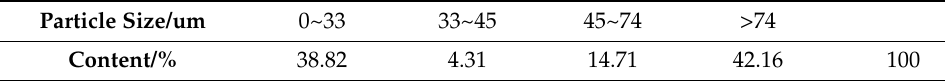
Figure 1. Main chemical properties of the tailings. Table 1. Particle size distribution of the tailings